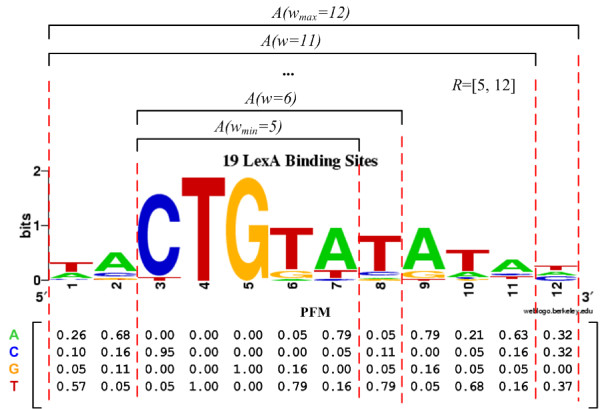
The generalized model. An example of the generalized model on the motif of 19 real LexA binding sites (the first 12 columns) from the SequenceLogo website. Each A(wi) is chosen based on the maximal P(A(wi)), where the bits bounded by the red dashes reflect P(A(wi)) for illustrative purpose. In practice, P(A(wi)) can be chosen flexibly.